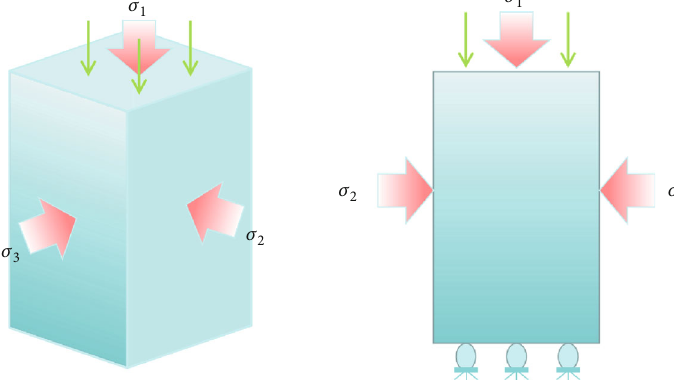
Figure 3: Geometrical model and boundary conditions of